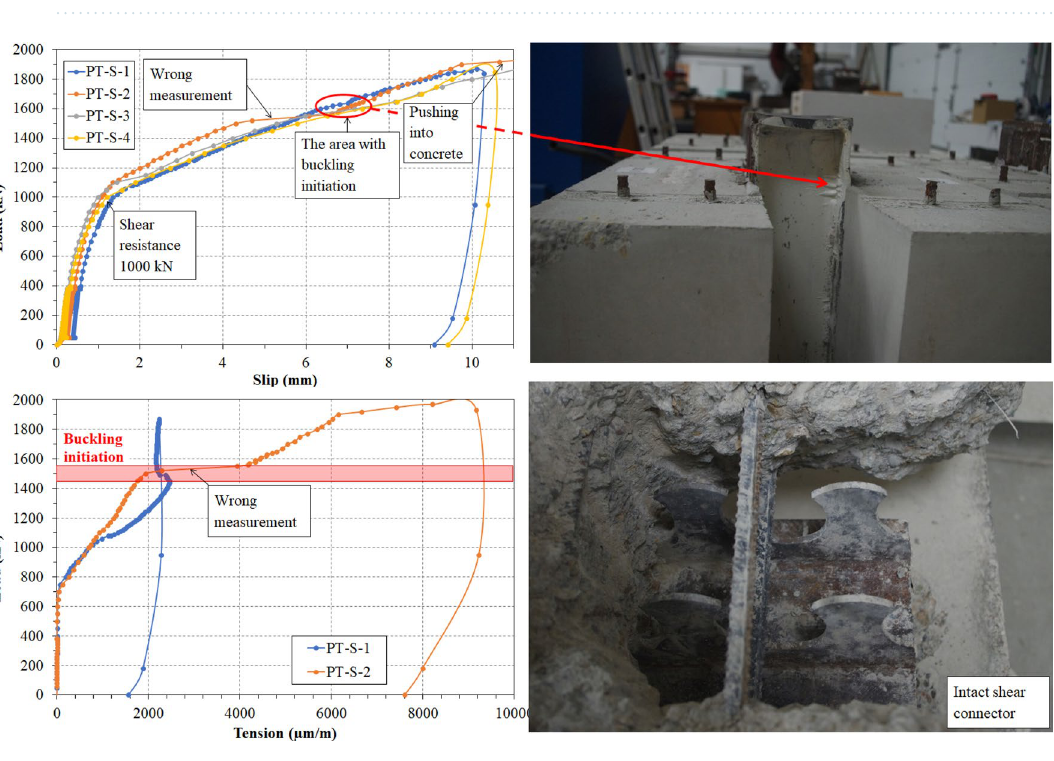
Figure 8. Results of the push-out